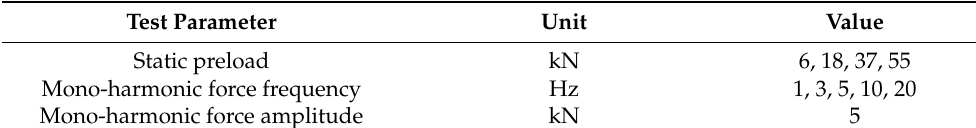
Table 2. Parameters of the tests to determine the dynamic properties of the elastomeric materials in the vertical direction.